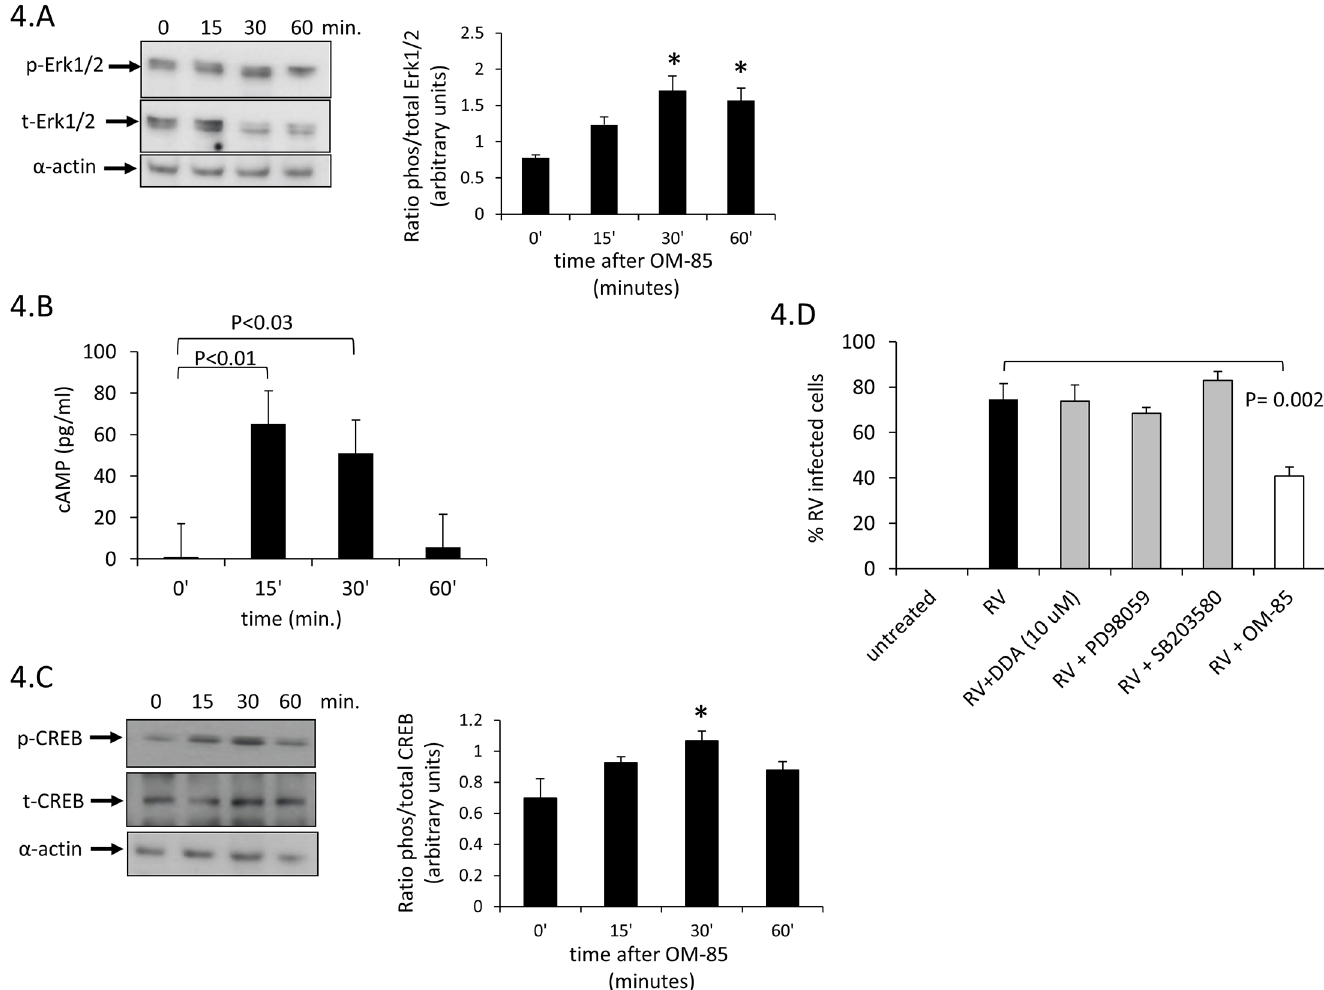
Fig 4. OM-85 induced various cell signalling. (A) Representative Western-blot of the ratio of total and phosphorylated Erk1/2 MAPK and bar chart analysisbasedon three additionalWestern-blots in BEC. (B) OM-85 inducedactivationof intracellular cAMP determined by ELISA in 5 BEC lines. Bars represent mean ± S.E.M. and asterix indicatesignificantdifference comparedto non-stimulated BEC. (C) Representative Western-blot of the ratio of total and phosphorylated CREB. Bar chart analysisbased on three additional Western-blotsin BEC. (D) RV infectionwas determinedby IF and was not affected by inhibitionof Erk1/2, p38 MAPK or cAMP (n =